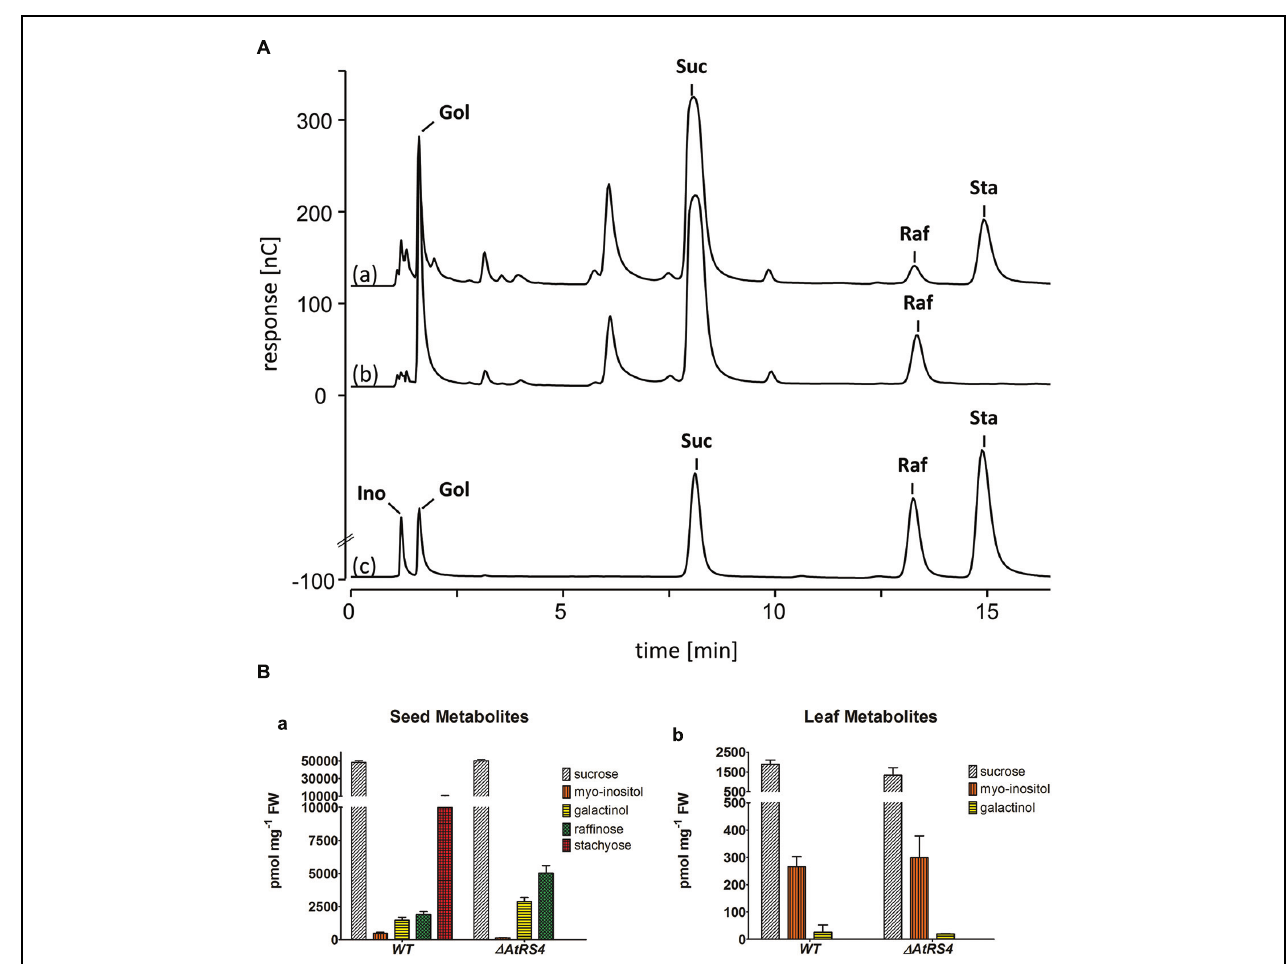
FIGURE 10 | Metabolite phenotype of (cid:2) AtRS4 mutant seeds. (A) HPAEC-PAD chromatogram of water-soluble carbohydrates (WSCs) and sugar alcohols extracted from (a) WT seeds, (b) (cid:2) AtRS4 mutant seeds and (c) 100 μ M Ino, Gol, Suc, Raf, and Sta as reference compounds. HPAEC-PAD chromatogram shows a total loss of Sta in (cid:2) AtRS4 mutant seeds. (B) Metabolite Phenotype of (a) WT and (cid:2) AtRS4 mutant seeds and of (b) WT and (cid:2) AtRS4 mutant leaves. Values are averages of three independently performed measurements ( ± SD).